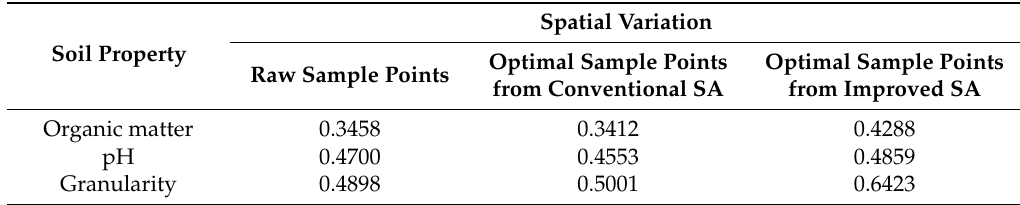
Table 3. Comparison of optimization results for different soil properties obtained using two simulated annealing (SA) algorithms.